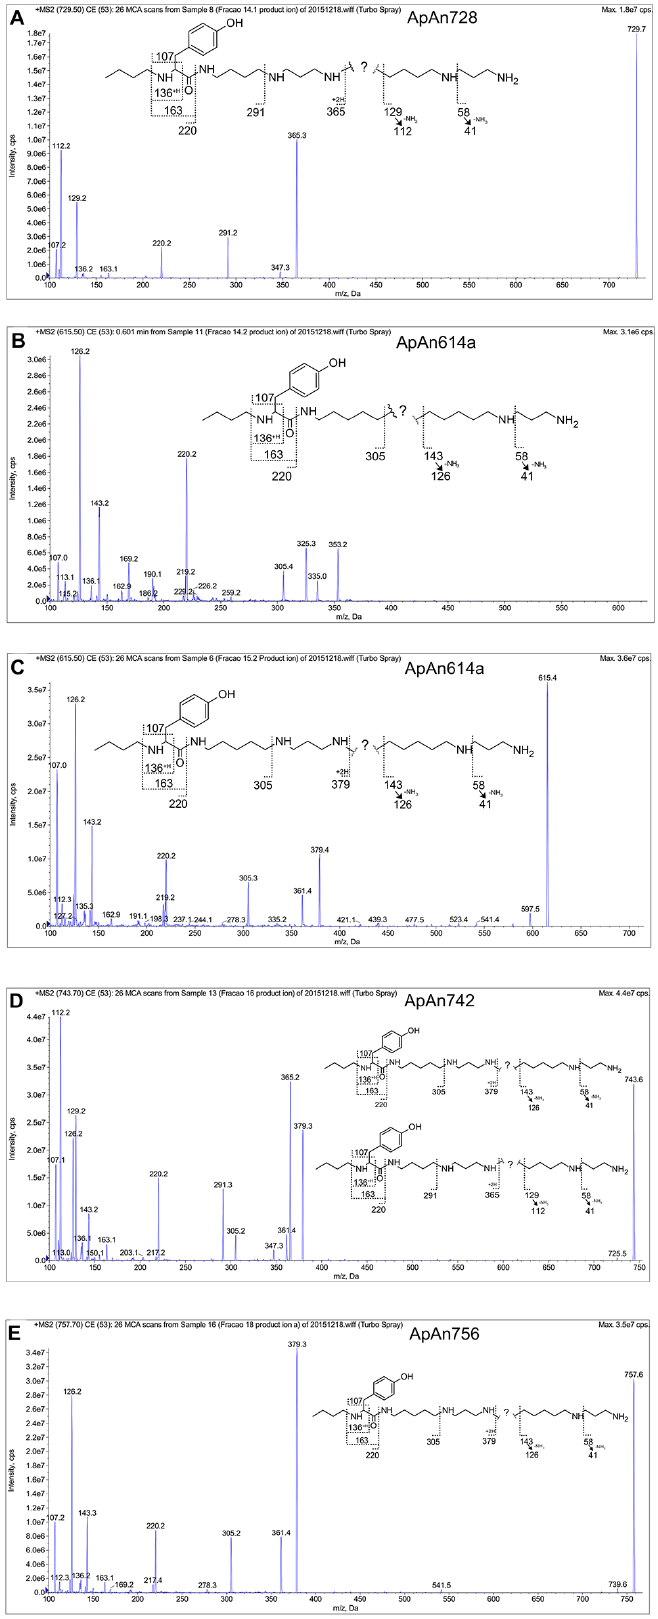
Figure 6. ESI-MS/MS spectra of the protonated ion [M+H]+ of (A) ApAn728, (B) ApAn614a, (C) ApAn614b, (D) ApAn742 and (E) ApAn756 and suggested partial chemical structure (inset). For (D) ApAn742, two structures were suggested due to possible co-elution of isomers in the